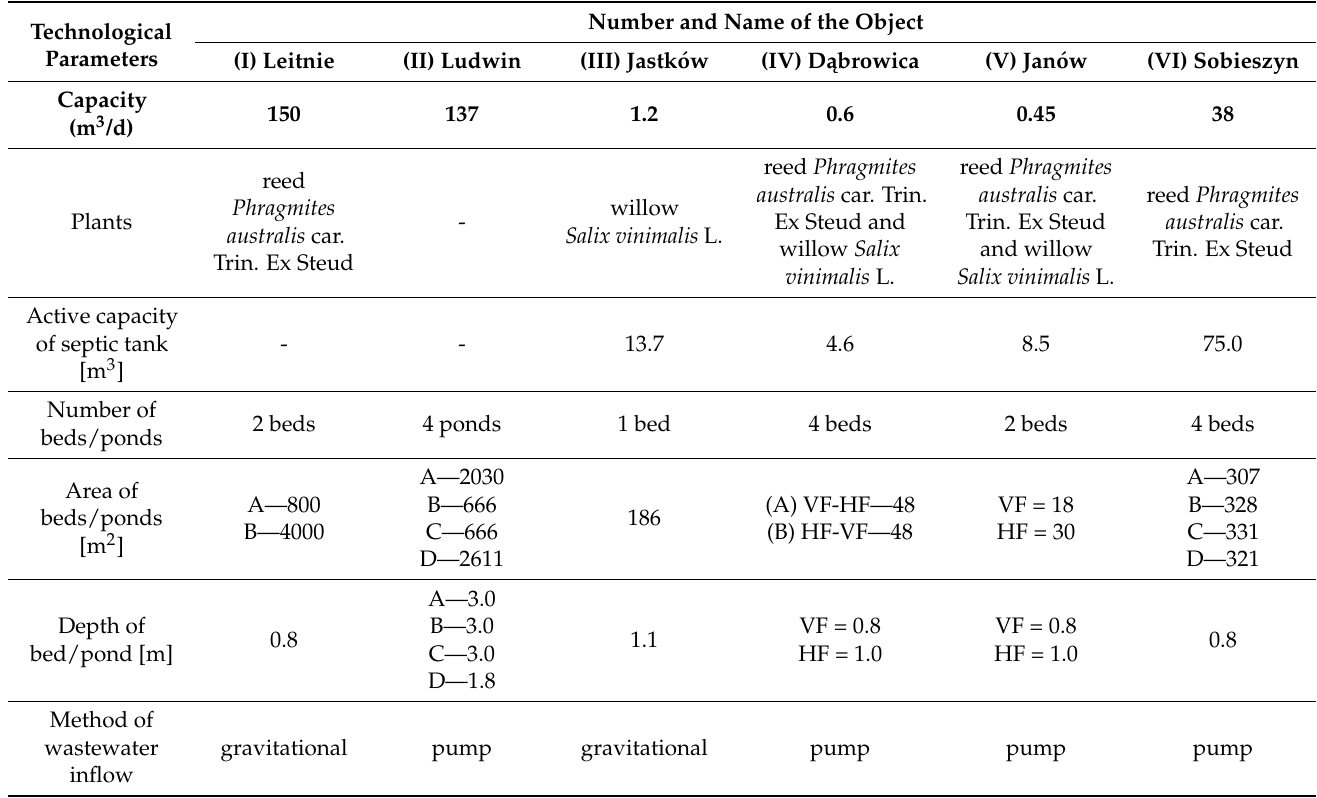
Figure 1. Location of the analyzed wastewater treatment plants; 1—Leitne; 2—Ludwin; 3—Jastków; 4—D ą browica; 5—Janów; 6—Sobieszyn. Table 1. Technological parameters of the studied small wastewater treatment plants in Lublin Province, Poland; VF—vertical flow, HF—horizontal flow.